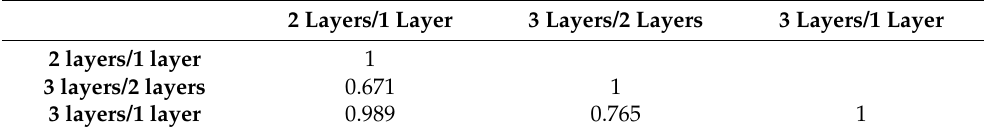
Table 4. Pearson coefficients of layer stacking.